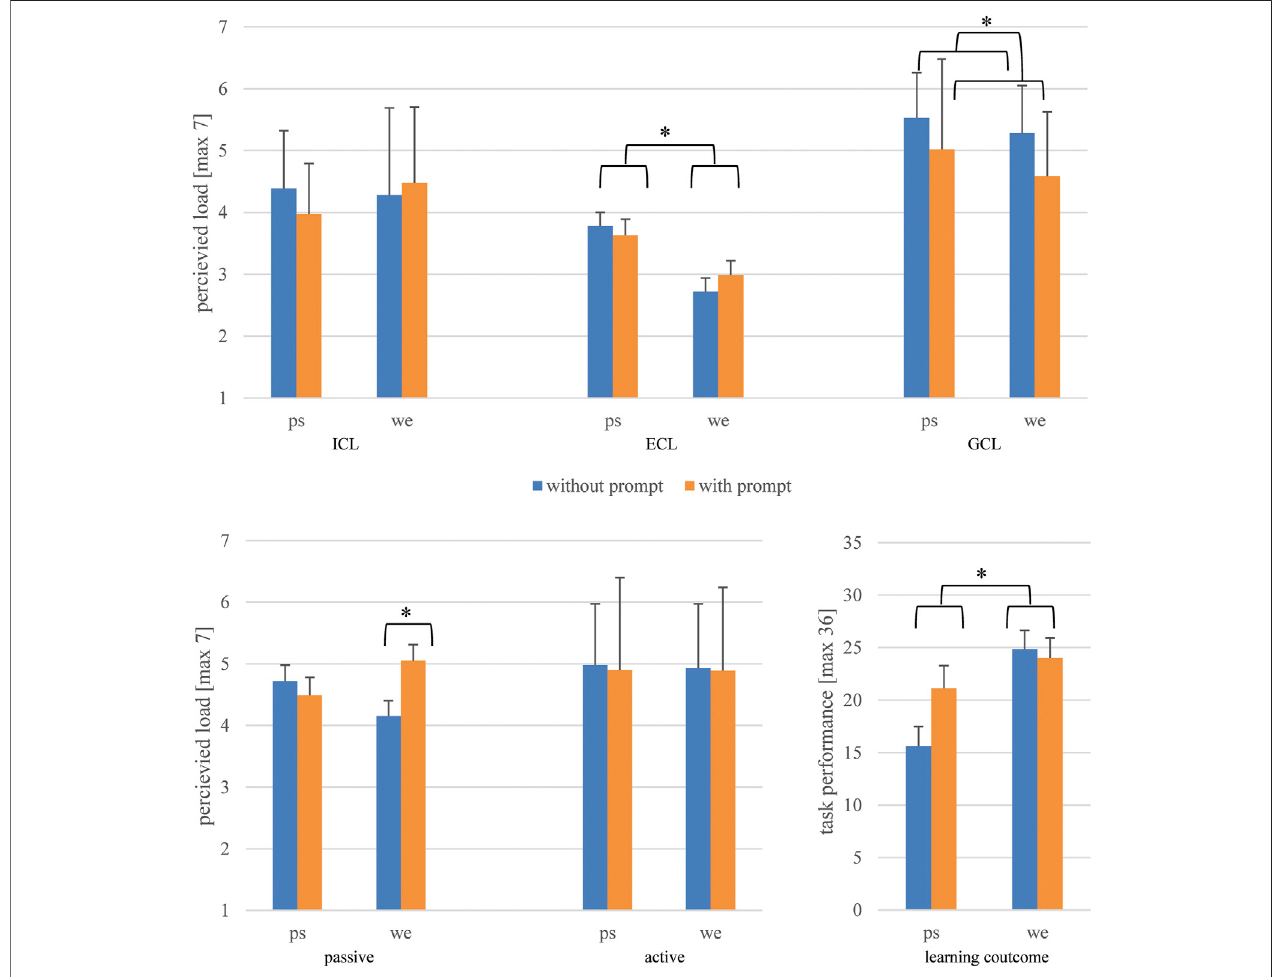
FIGURE 1 | Effects on the dependent variables for study 1. Note: ps (cid:1) problem-solving, we (cid:1) worked examples; * (simple) main effect with p ≤ 0.05.